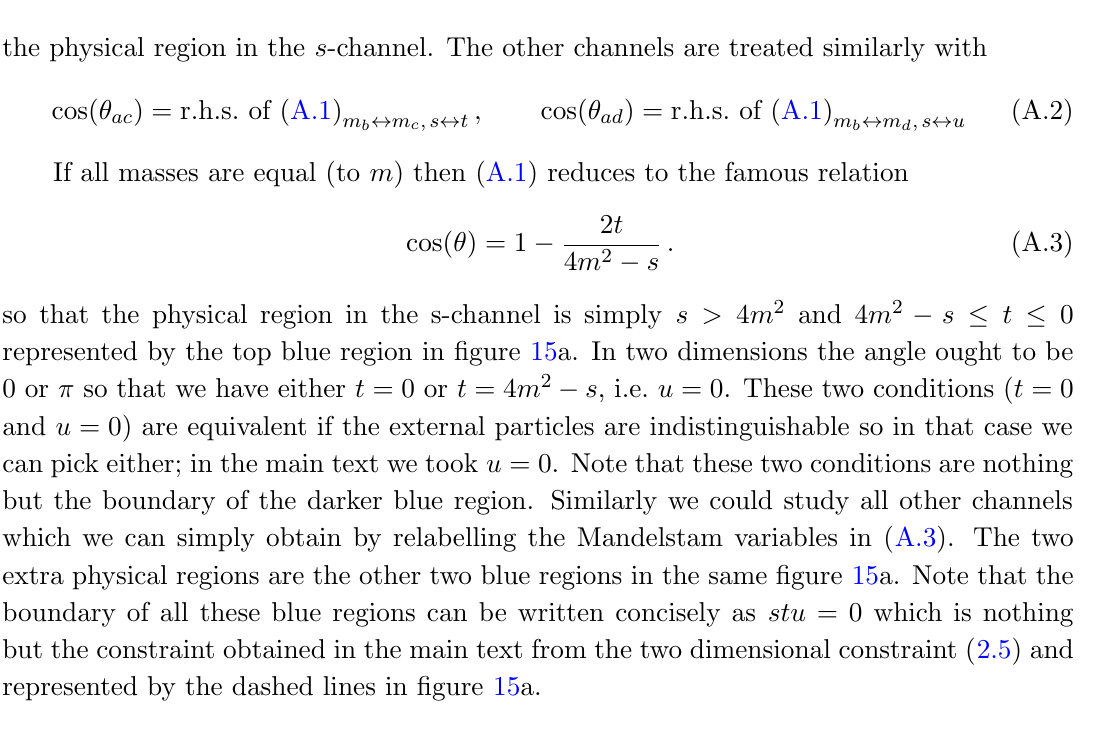
t < max(( m a + ^ m 2 m 2 m 2 m 2 ) = p 3 as in the a (cid:0) c (cid:0) b (cid:0) d (cid:0)